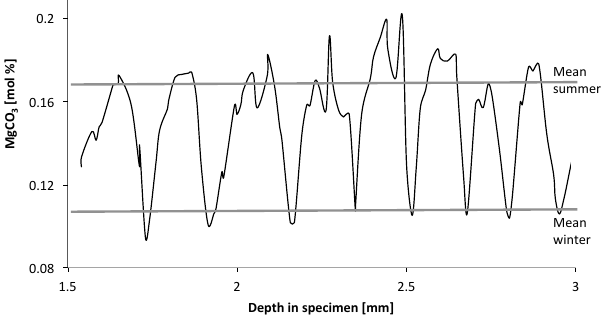
Figure 14. Annual cycles of MgCO 3 content of C. compactum mound from 15 to 20m in the Kingitok Islands in north-central Labrador. Cycles show V-shaped pattern, indicating growth halt during winter. Water temperature at Kingitok is below 0 ◦ C for over 200 days per year, and sea surface is typically frozen from early December to late June (Adey et al.,